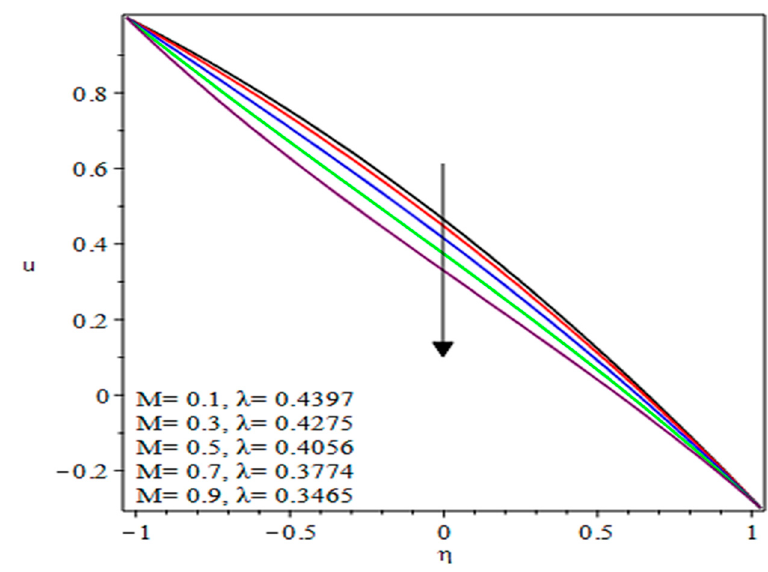
Figure 6. MHD parameter M influence on the velocity profile at ξ = 0.25 by fixing K = 0.1 and ζ = 2.